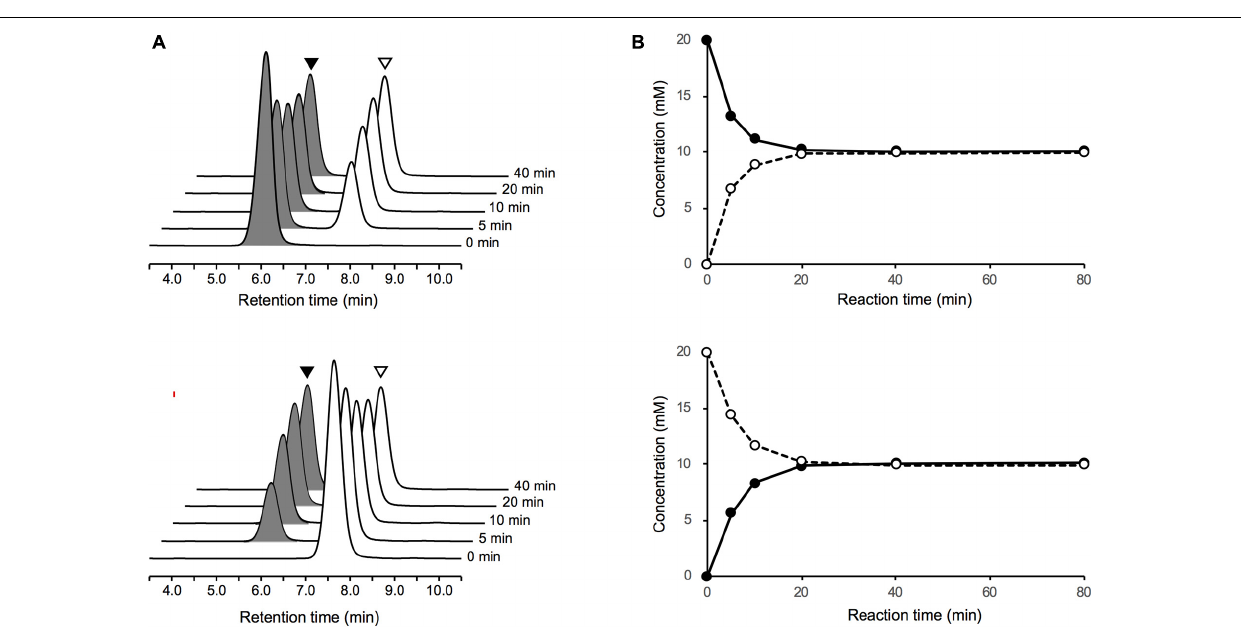
Frontiers in Microbiology |